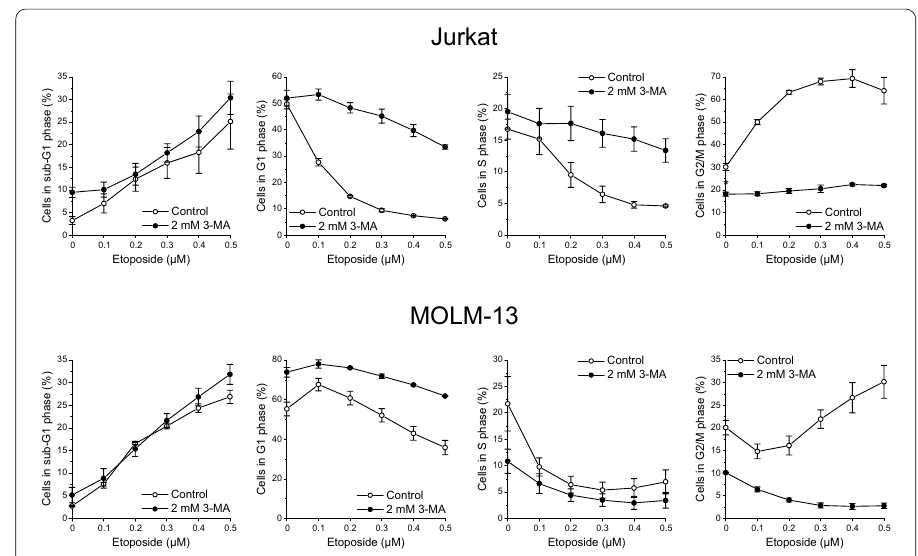
Fig. 1 Autophagy inhibition affects etoposide‑induced cell cycle arrest. Cells were exposed to etoposide with or without 3‑MA for 48 h. Cell cycle phases were determined by flow‑cytometric analysis of PI‑stained ethanol‑fixed cells. Mean SEM of three independent measurements is ±